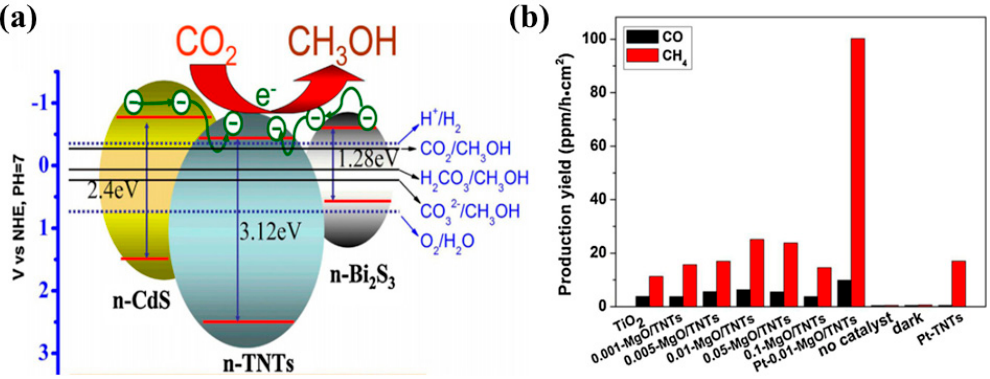
Figure 1. ( a ) Proposed mechanism of photocatalytic CO 2 conversion to CH 3 OH employing CdS and Bi 2 S 3 TNT photocatalysts (taken with permission from [47]). ( b ) Production yield of CO and CH 4 from Pt-MgO-covered TNN films (taken with permission from [48]).